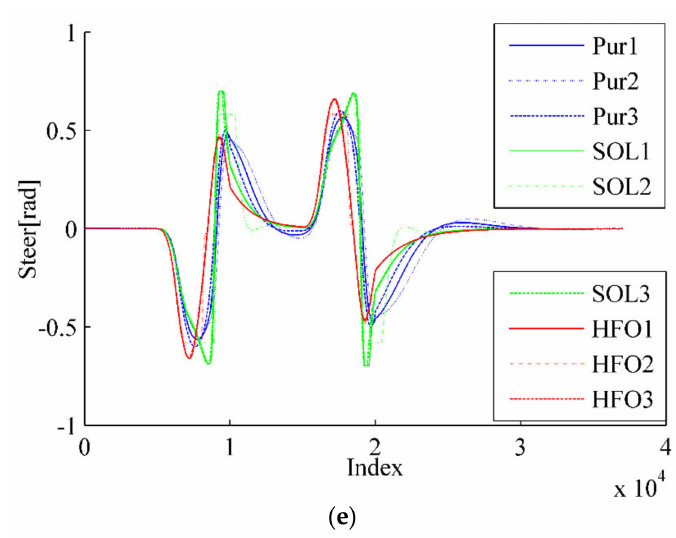
Figure 7. Double lane-changing test scenario. ( a ) Trajectory tracking (3D), ( b ) Trajectory tracking (2D), ( c ) Lateral error, ( d ) Heading angle, ( e ) Steer angle.